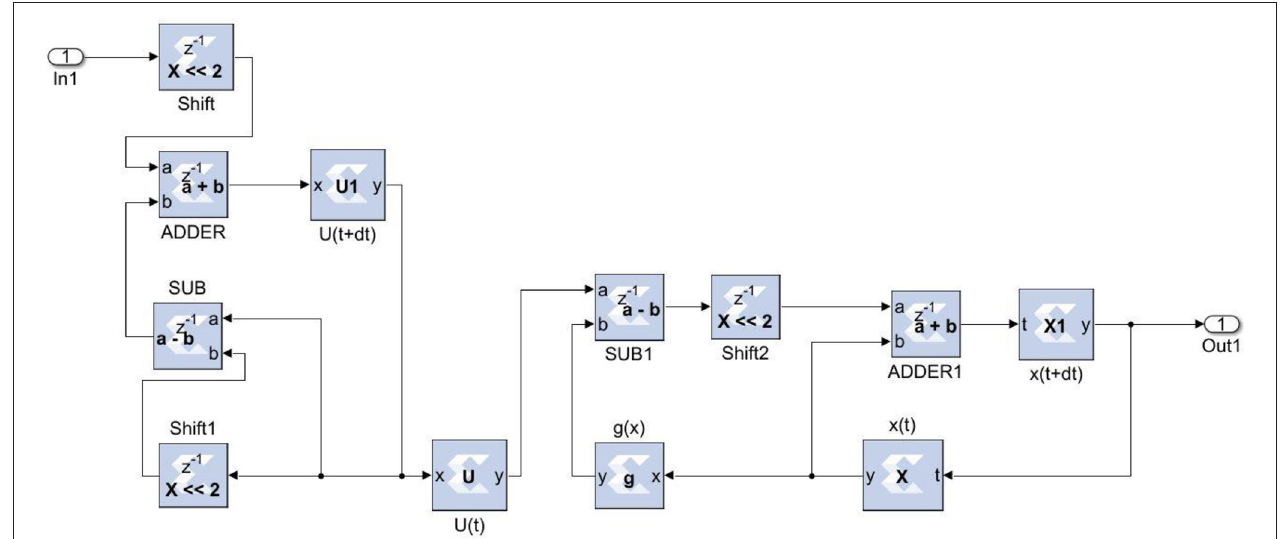
FIGURE 8 | Neuron model.